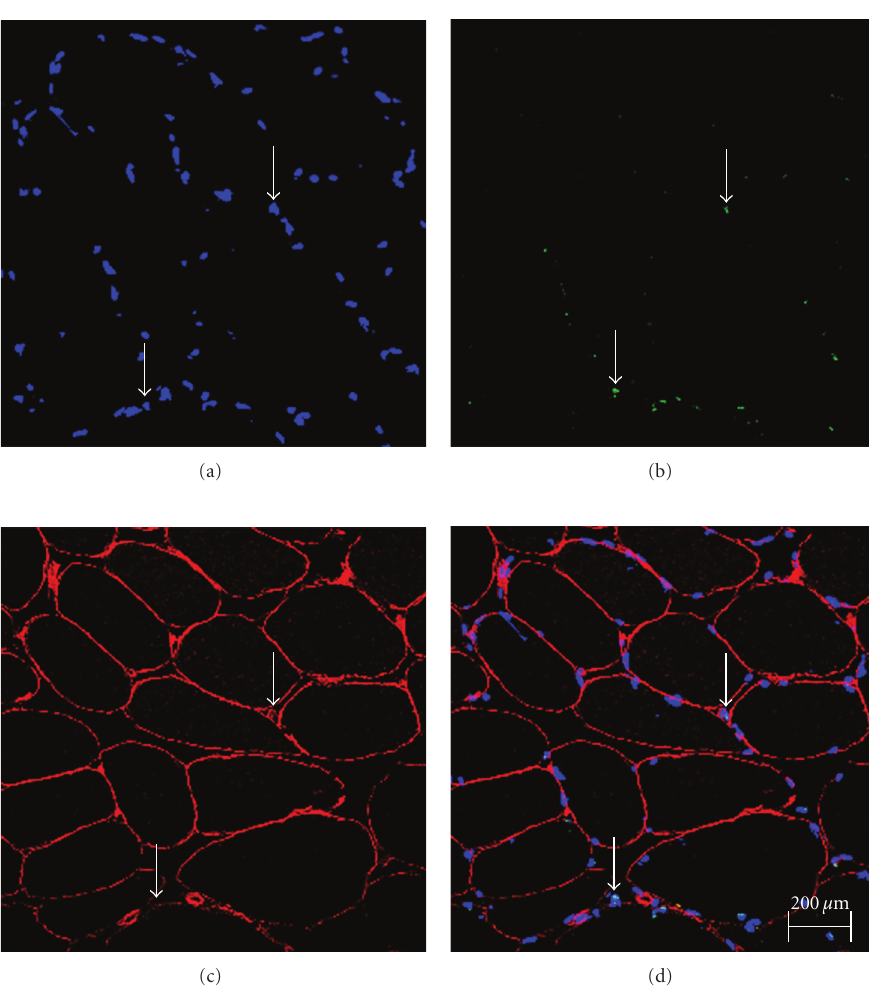
Figure 2: Examples of tissue cross-sections. (a) DAPI-stained nuclei. (b) Apoptotic nuclei as indicated by the TUNEL assay. (c) The basal lamina of fibers was identified by immunocytochemistry. (d) Overlay of DAPI, TUNEL, and lamina staining. The arrows indicate examples of apoptotic